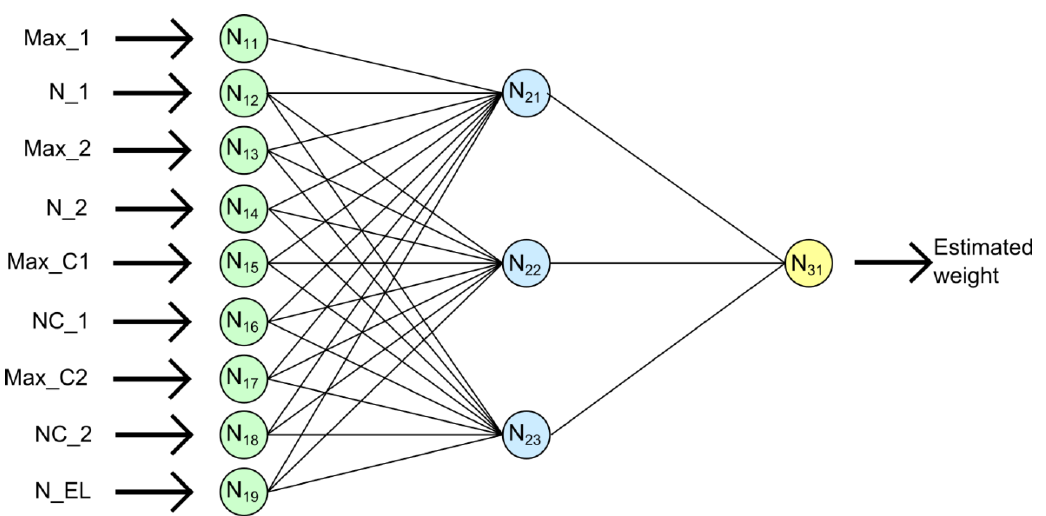
Figure 4. Proposed MLP